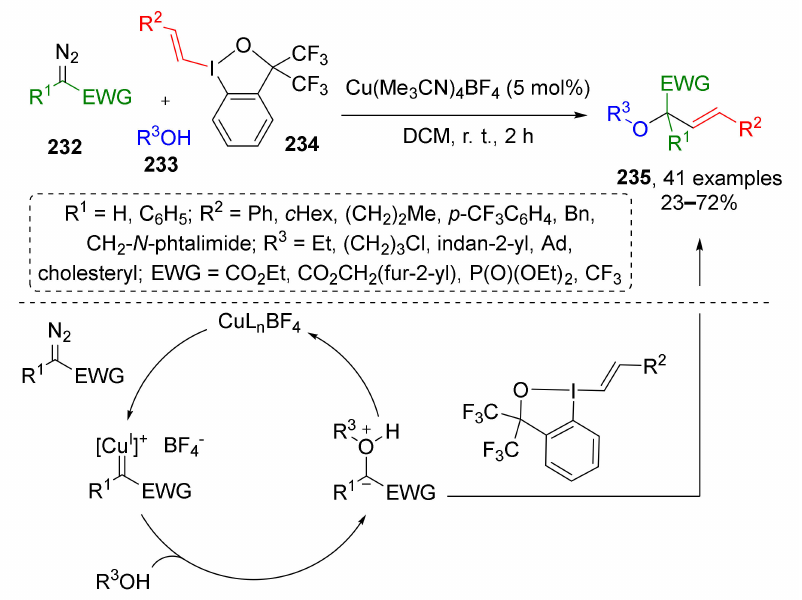
Scheme 68. Copper-catalyzed oxyvinylation of diazo